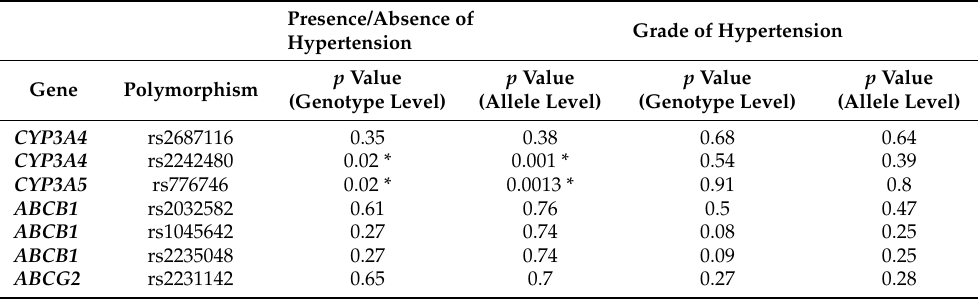
Table 8. p value by chi-squared test at genotype and allele level for the presence/absence and grade of hypertension. Correlation between hypertension side effect and polymorphisms linked to MKI